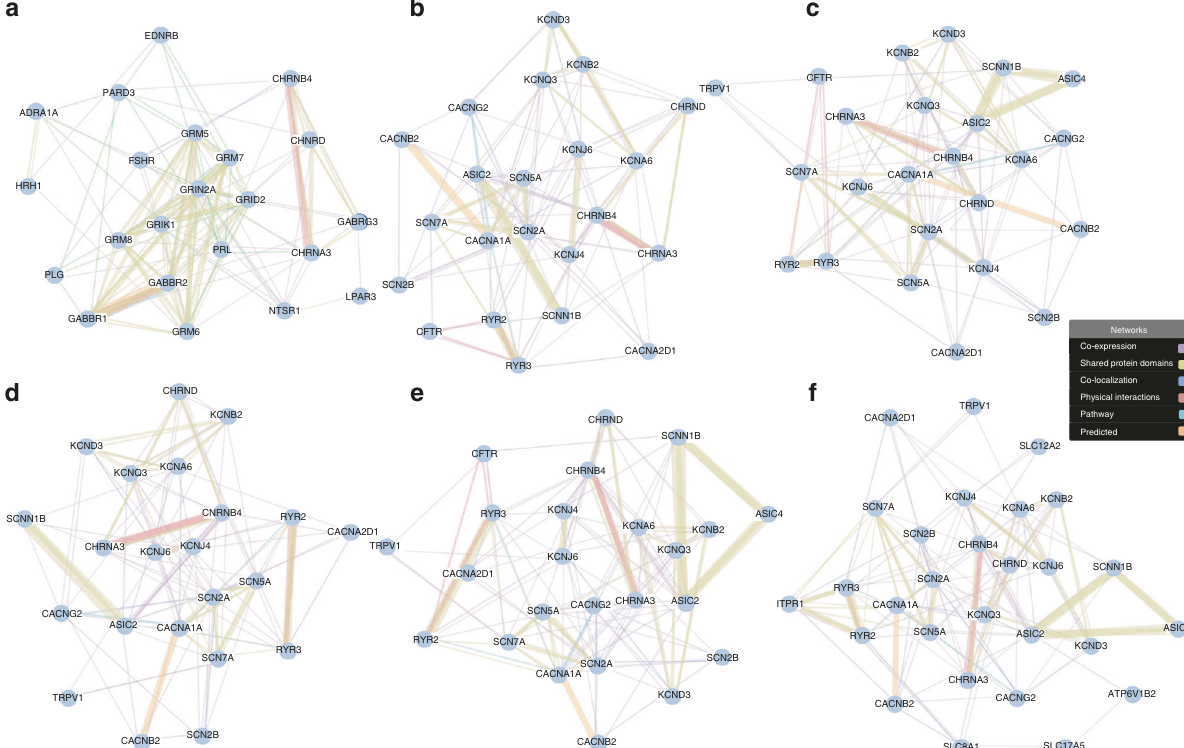
Fig. 2 Gene network of the susceptibility pathways/GO terms. Each node is a gene, which was the selected gene in our GWAS pathway analysis and is shown in Supplementary Data 4. The connecting lines are drawn if the two genes have a relationship such as co-expression, shared protein domain, physical interactions, co-localization, or pathway. The thickness of the lines represents the degree of similarity between two genes. Gene network is produced using GeneMANIA. a The network of KEGG neuroactive ligand receptor interaction pathway consists of 23 genes and only TRPV1 in the associated gene list identi fi ed by our GWAS enrichment was shown no direct relationship with other associated genes. b The network of gated channel activity GO term consists all of 22 genes identi fi ed by our GWAS enrichment. c The network of ion channel activity GO term consists all of 24 genes identi fi ed by our GWAS enrichment. d The network of cation channel activity GO term consists all of 22 genes identi fi ed by our GWAS enrichment. e The